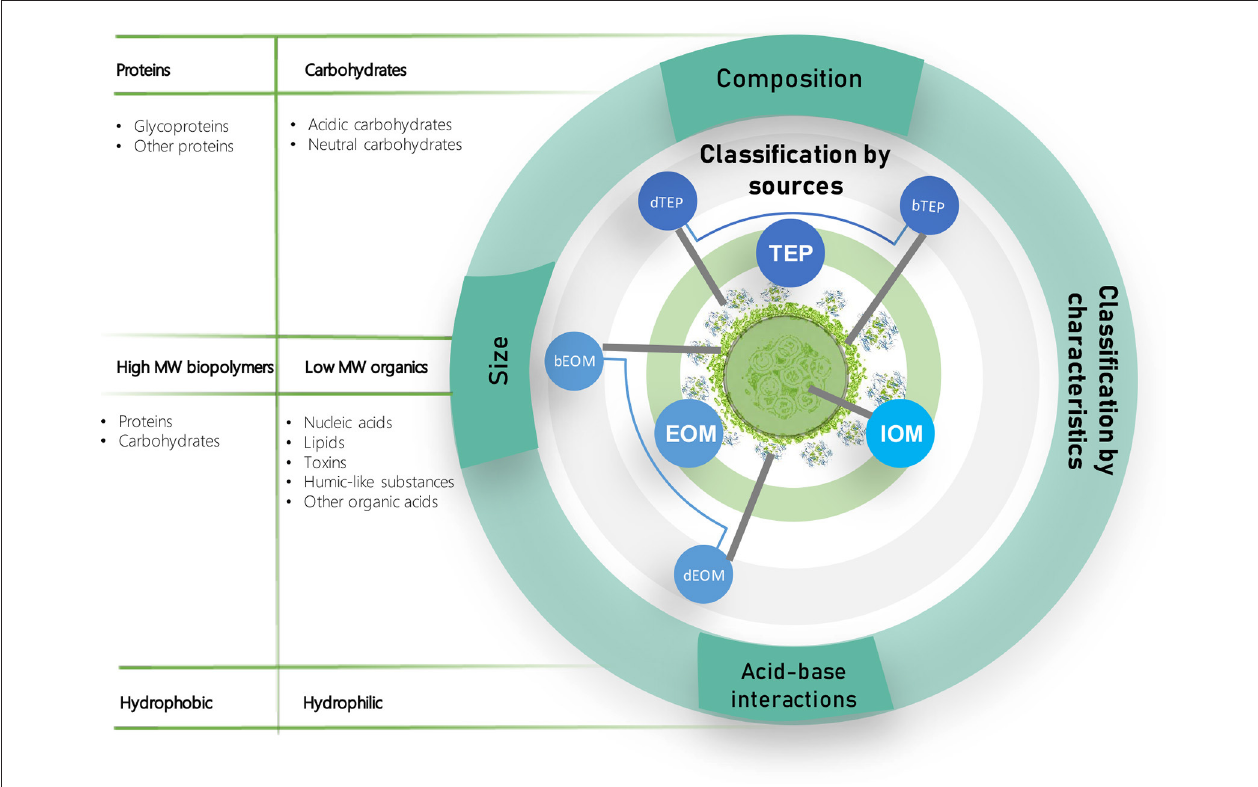
FIGURE 2 | Algal organic matter (AOM) classification according to sources and characteristics. The AOM is considered the main contributor to irreversible fouling in algal membrane separation processes. The AOM can form gel-like structures and irreversibly attach to the membrane pores and